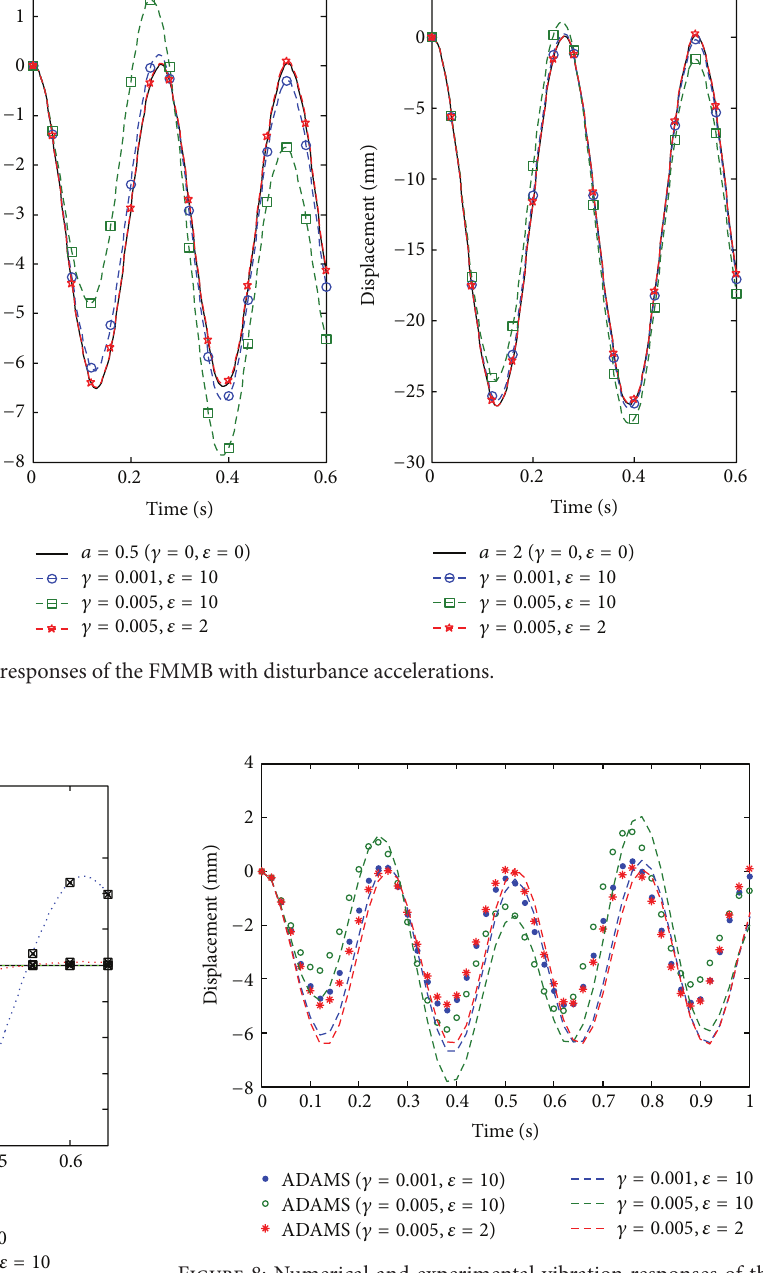
Figure 8: Numerical and experimental vibration responses of the FMMB ( 𝑎 = 0.5 m/s 2